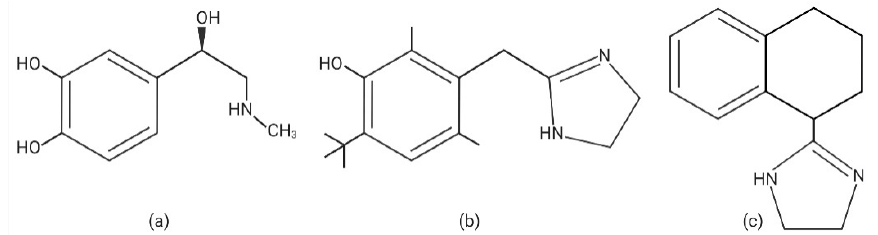
Figure 1. ( a ) epinephrine with a root benzene ring ( b ) oxymetazoline has an imidazoline ring in- Figure 1. Catecholamines and Imidazoline Derivatives. ( a ) epinephrine with a root benzene ring corporated into the benzene ring structure ( c ) tetrahydrozoline (also known as tetryzoline) has an ( b ) oxymetazoline has an imidazoline ring incorporated into the benzene ring structure ( c ) tetrahydro- imidazoline ring bound to a polycyclic aromatic naphthalene. zoline (also known as tetryzoline) has an imidazoline ring bound to a polycyclic aromatic naphthalene.